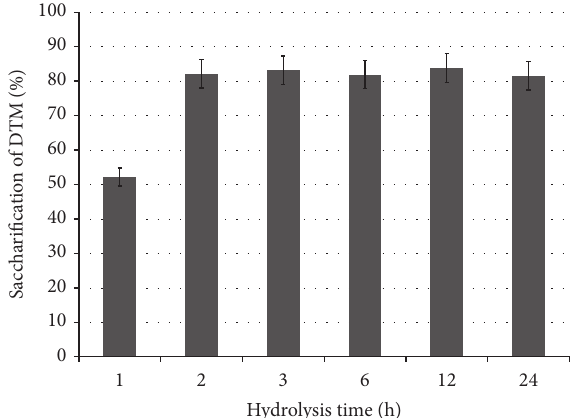
Figure 4: The kinetics of saccharification of dextranase-pretreated mutan (DTM) using T. harzianum mutanase induced by (1 → 3)- 𝛼 - d-glucan isolated from mycelium of C. unicolor